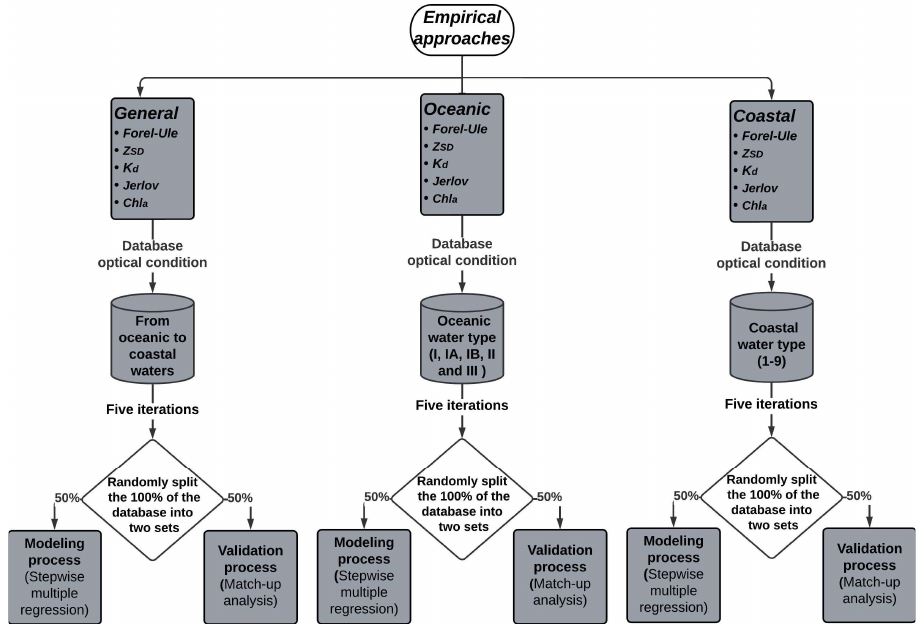
Figure 4. Scheme of approaches for each optical parameter and the database used for its develop- ment.